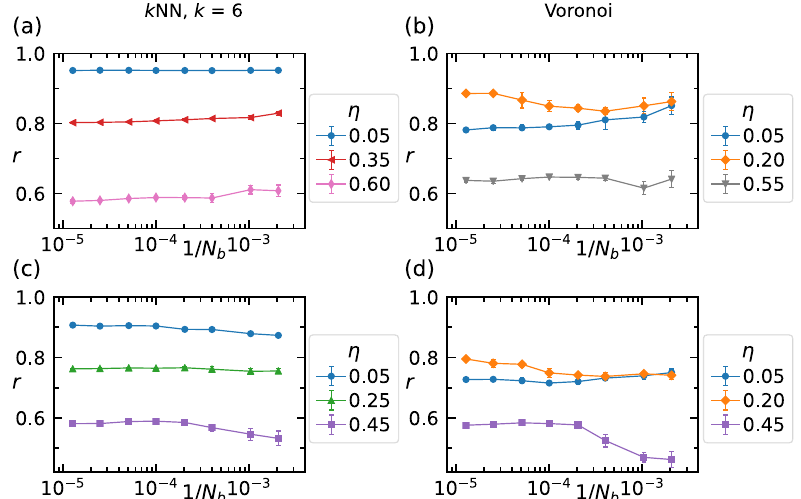
Fig. 4 Probing the existence of long-range order. Polar order parameter r vs inverse system size 1/ N b at different noise values ( η ) and obstacle densities ( ρ o ). Panels a , c correspond to k -nearest neighbors interaction ( k NN, k = 6 where k is the number of neighboring objects), and panels b , d are for Voronoi interaction. a , b ρ o = 0.051 and c , d ρ o = 0.153. Error bars represent the standard deviation of the polar order parameter over different realizations of the obstacle fi eld (see “ Methods ” ). Note that error bars are often comparable or smaller than the symbol size.